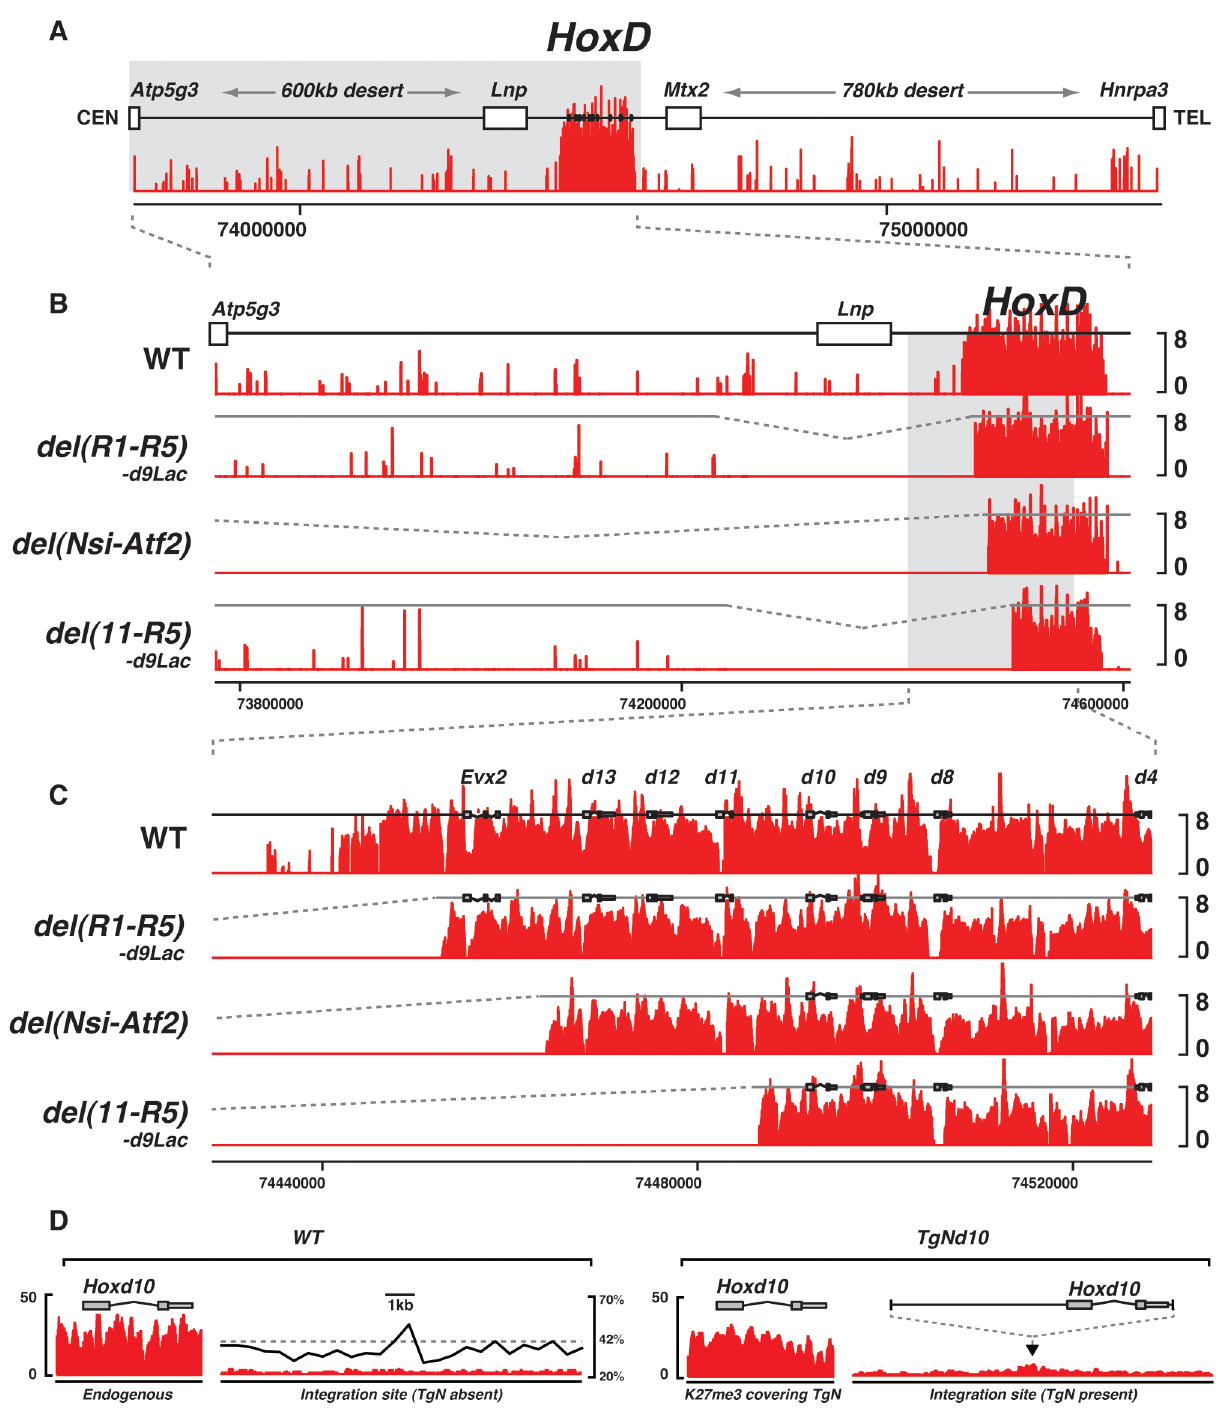
Figure 3. Effect of large deletions upon the H3K27me3 profiles. (A) Wild type genomic landscape of the murine HoxD cluster. The log2 profiles of H3K27me3 enrichment are depicted in red. (B–C) H3K27me3 profiles of either wild type, or animals harboring a deletion of the 5 9 border of the H3K27me3 domain. Genotypes are specified on the left. (D) H3K27me3 profiles over the endogenous (left) and transgenic (right) Hoxd10 sequence and over the integration site, in the presence or absence of the transgene. Wild type GC density using a 500 bp sliding window is depicted by the black line (right panel). TgNd10 was deleted, suggesting that the recruitment of PRC2 may H3K27me3 over the entire DNA fragment (Fig. 4B, TgNd10Lac ). be independent of transcription (Fig. 4B, TgNd10 h TSS ) [56]. Similar results were observed when the CpG26 sequences had been removed (Fig. 4B, TgNd10 ). Moreover, similar amounts of Finally, when the second CpG island was excised, the H3K27me3 H3K27me3 were scored when the transcription start site of profile again remained unmodified, showing that CpG rich regions